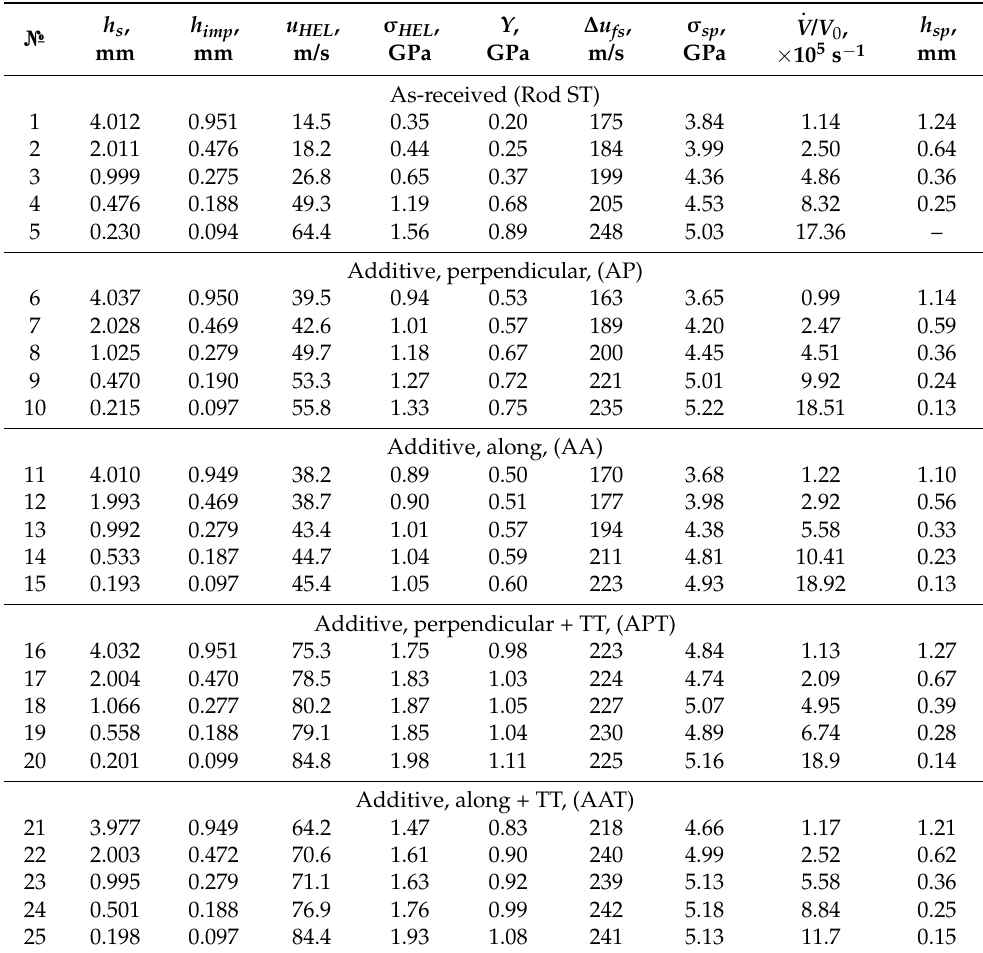
Table 3. Setting up experiments and results of processing experiments with samples of the as-received cast and additive alloy Inconel